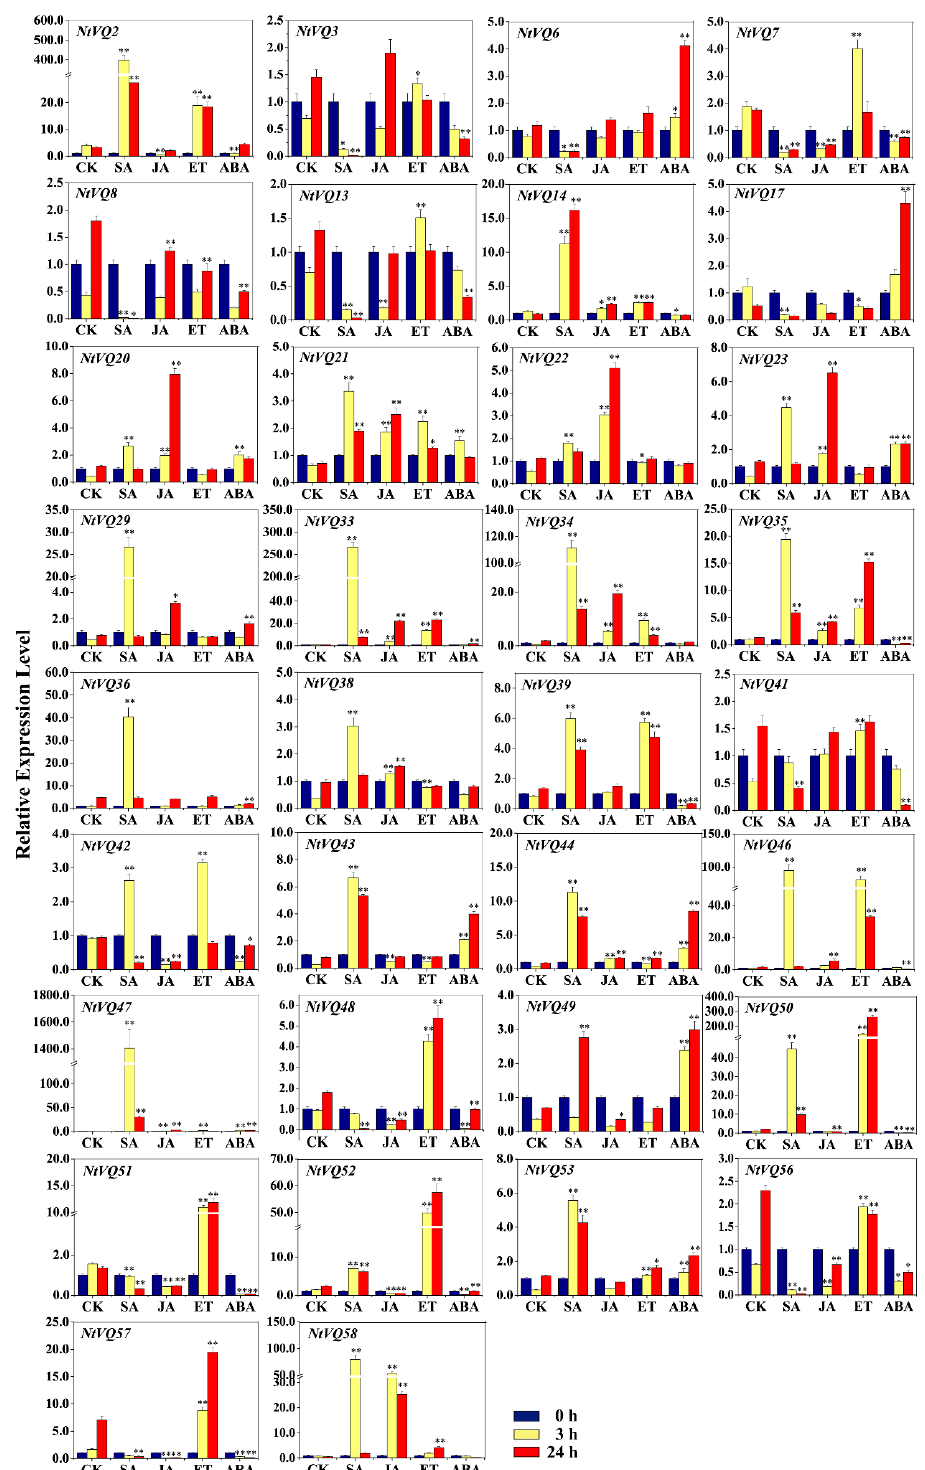
Figure 4. Expression analysis of significantly modulated NtVQ genes in response to different phytohormones. Two-week-old seedlings were treated with 2 mM SA, 100 μ M JA, 1 mM ET, or 100 μ M ABA for 0, 3, and 24 h before the whole seedlings were harvested for RNA isolation and qRT-PCR. The relative expression value of each NtVQ gene was normalized to NtEF1 α with CK at 0 h as calibrator. CK, control group treated with 0.1% DMSO. * indicates the level of significance relative to the CK value (* p < 0.05, ** p < 0.01).